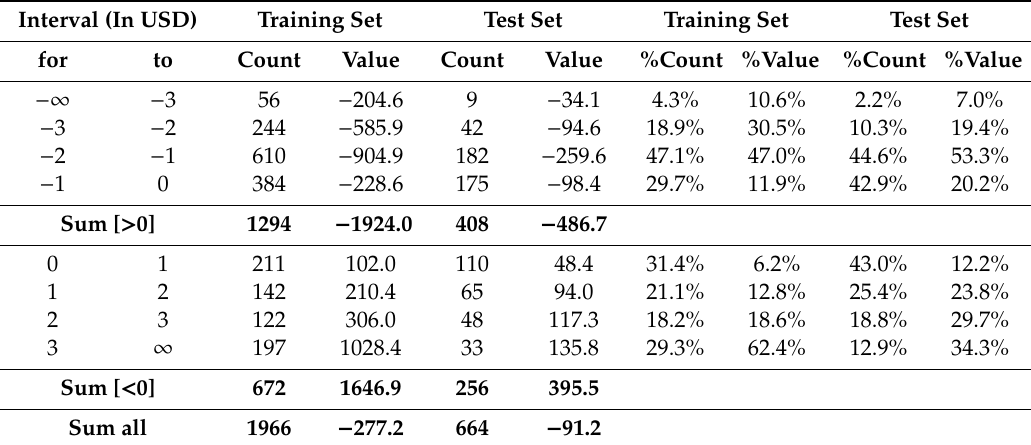
Table 3. Characteristics of training set and test